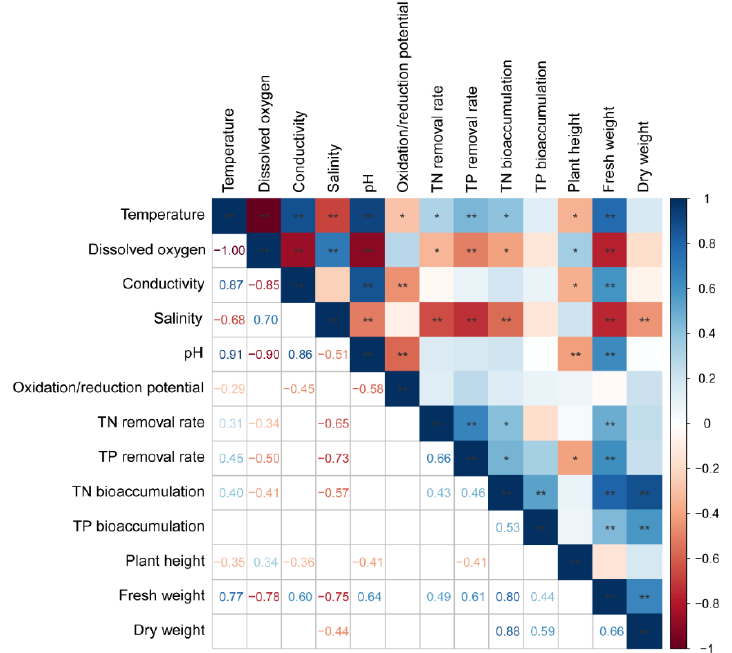
Figure 6. Correlations among water quality parameters, TN and TP removal rates, TN and TP bio- accumulation, and biomass. Numbers indicate the Pearson’s r between two parameters with signif- icant correlation; * significant correlation, p < 0.05; ** extremely significant correlation, p < 0.01.